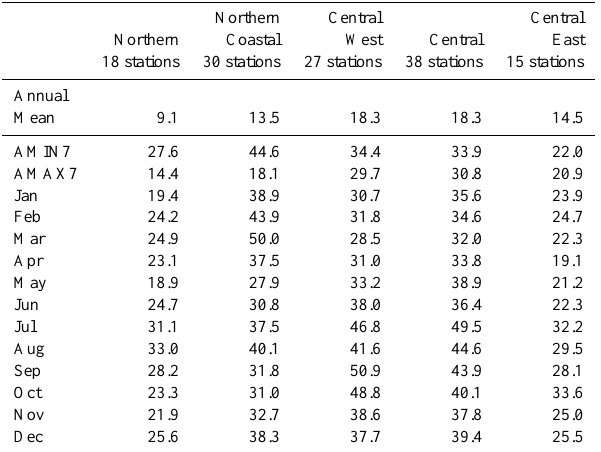
Table 1. Cluster homogeneity metrics: the sum of all Euclidean dis- tances between the LOESS STD SM time series in each region, normalised by number of stations in the region. The metric is shown for each region/indicator combination. Smaller values indicate more homogeneous